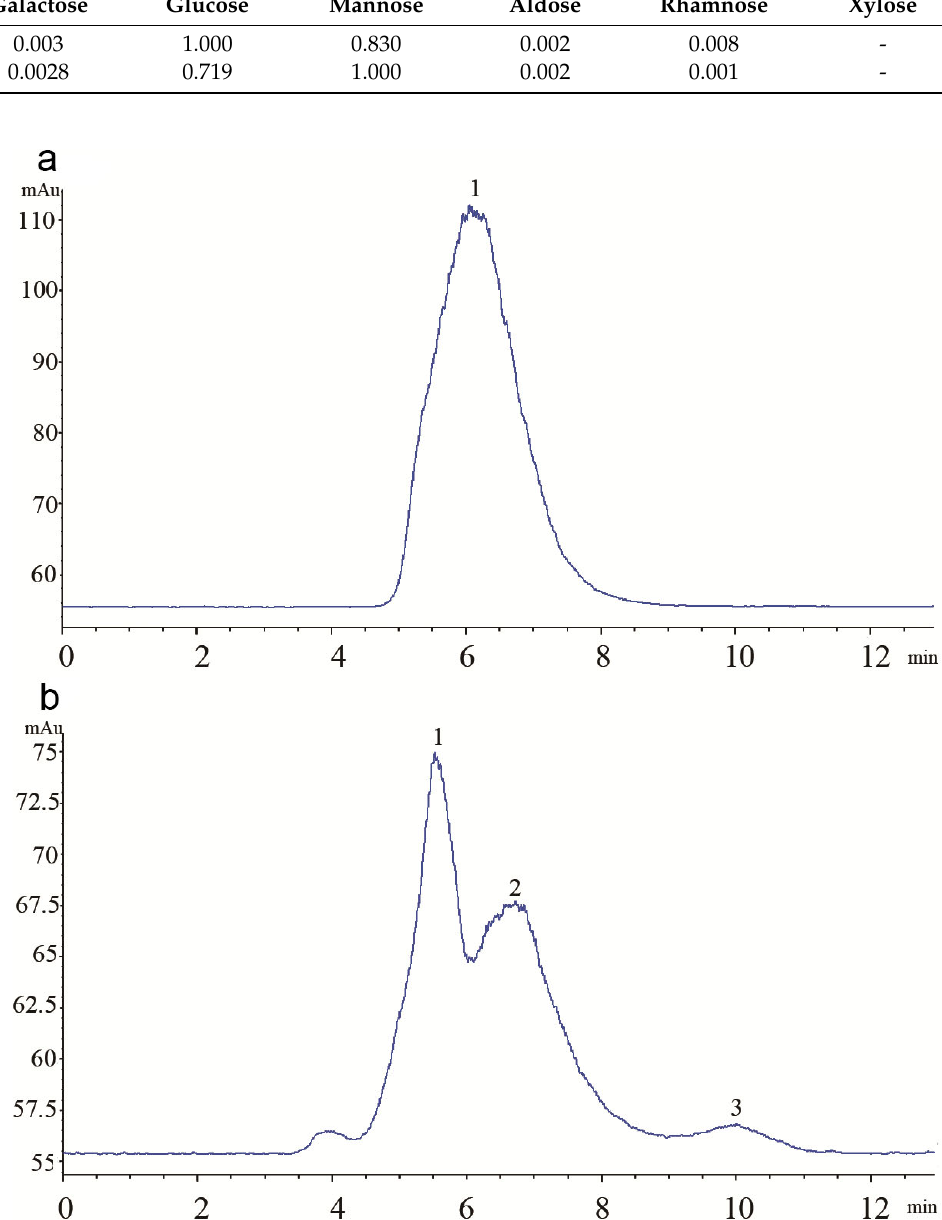
Figure 4. The molecular weight analysis of the FDOP ( a ) and DDOP ( b ) was shown by HPLC ‐ GPC.